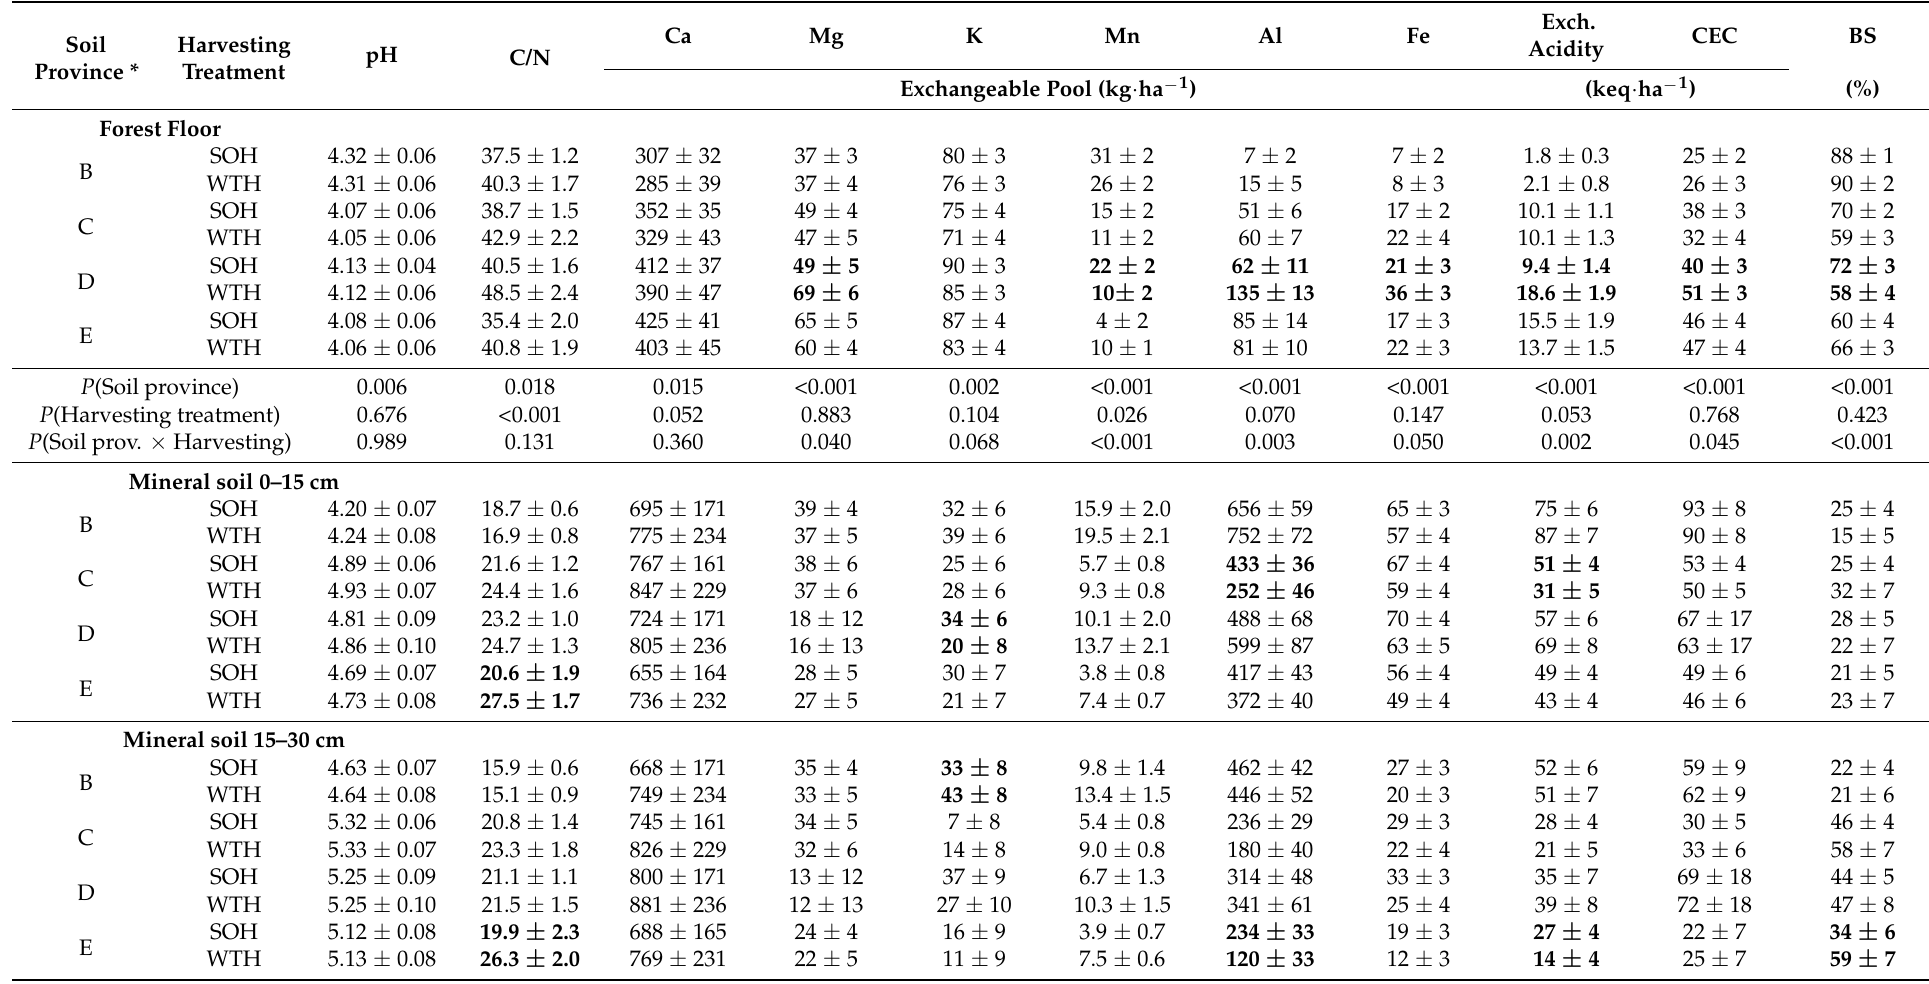
Table 3. Effect of harvesting treatment (SOH: stem-only harvesting, WTH: whole-tree harvesting) on soil exchangeable element pools and properties, by soil province. Values are model-adjusted means ± standard errors. Values in bold indicate a significant difference ( p ≤ 0.05) between harvesting treatments within a given soil